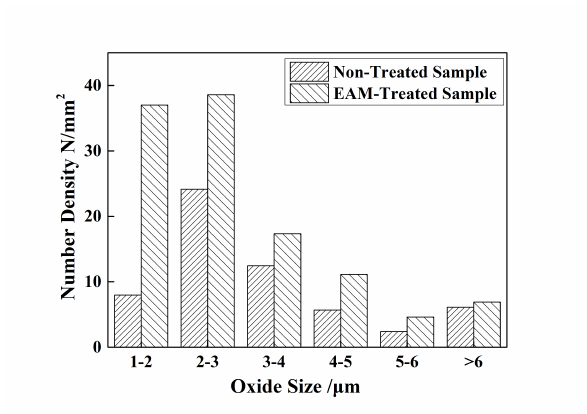
Figure 2: The relationship between oxide size and number density in EAM-treated sample and Non-treated sample